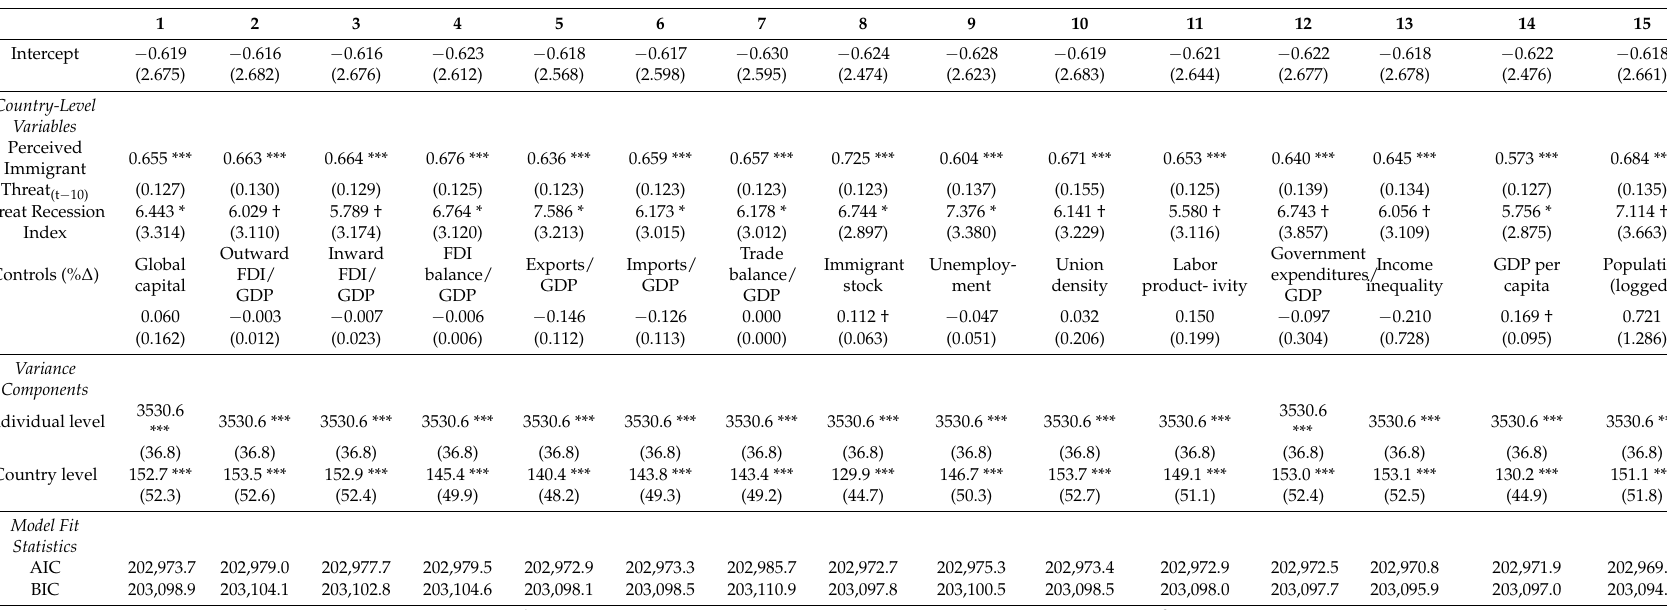
Table 6. Determinants of perceived immigrant threat controlling for changes of country-level variables, 2003–2013 ( n = 18,433 individuals nested within 22 countries).